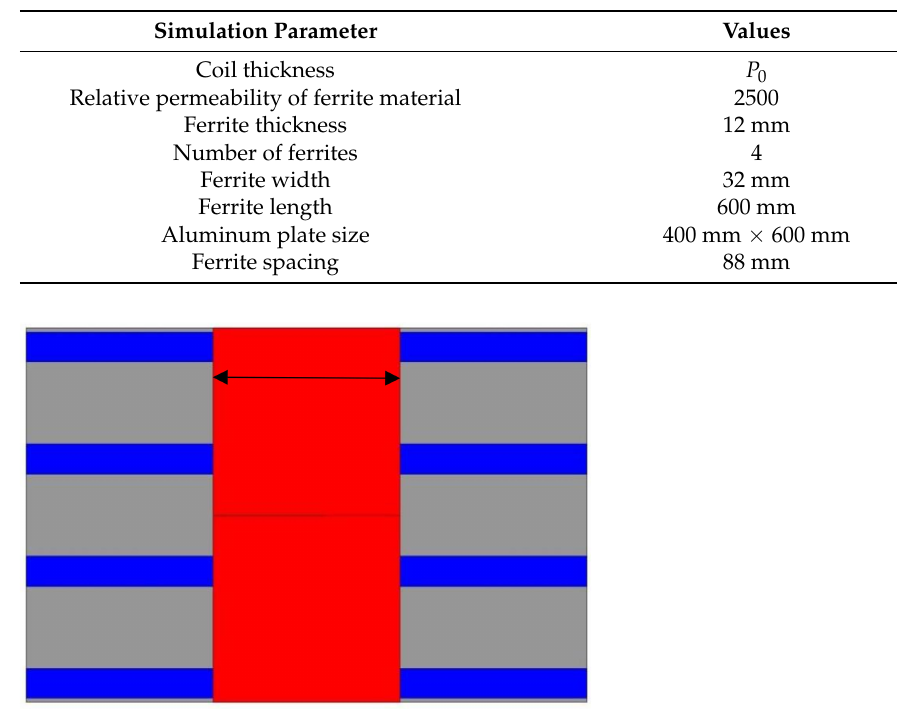
Table 6. Key parameters of solenoid-structure transformer.